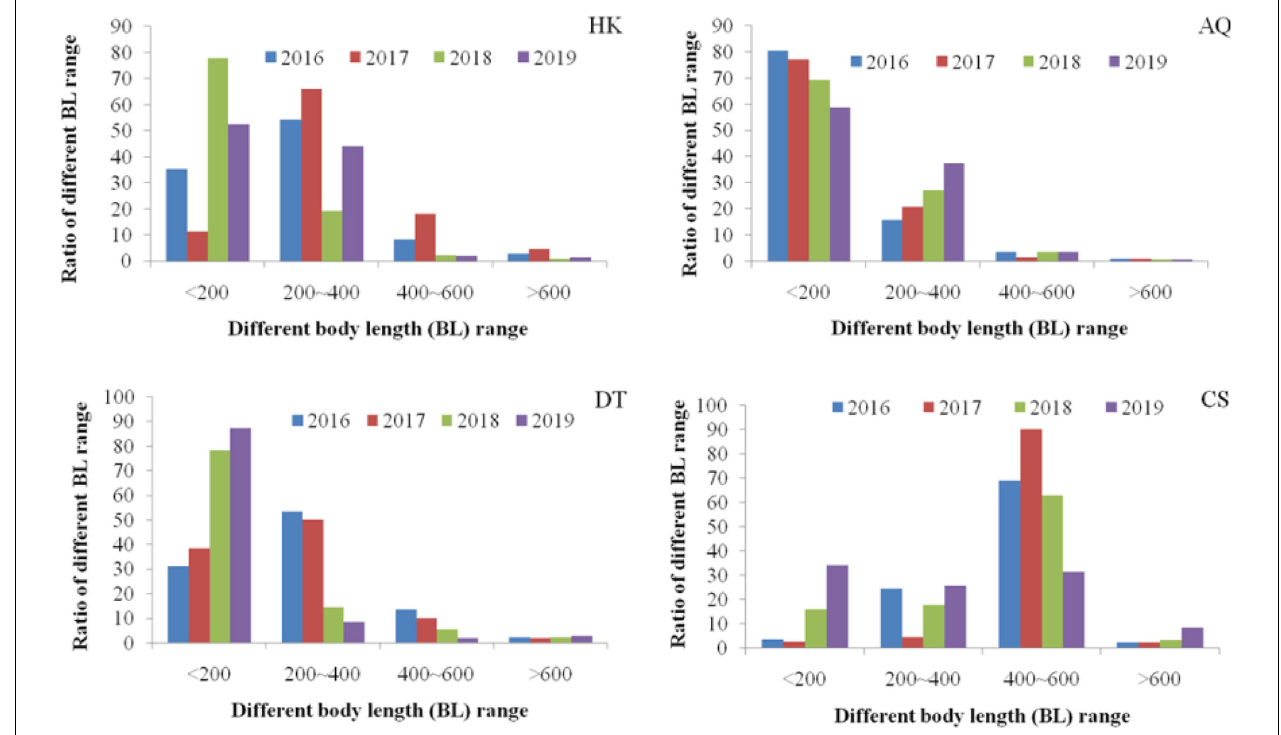
FIGURE 2 | Body weight range ratio in different